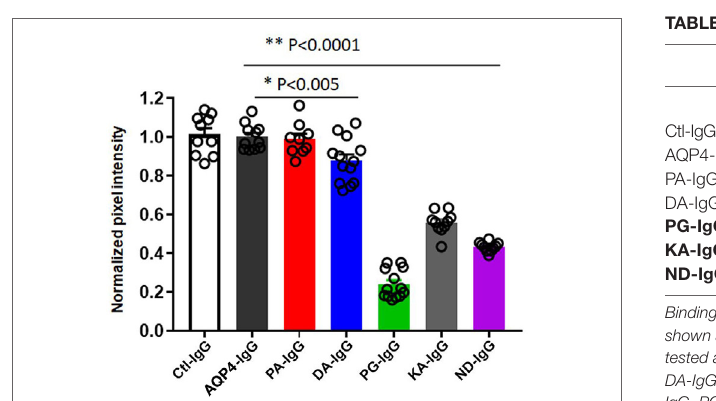
FigUre 4 | Quantification of transplacental transport of antibodies. Quanitification of optical intensity of the infrared signal (pixel intensity) from embryos exposed to maternal infrared labeled antibodies in utero . The values of each embryo is averaged and shown normalized to the average pixel intensity of an AQP4–IgG exposed litter present on the same scan to account for variability within scans (normalized pixel intensity). Transplacental transport of each antibody is shown for both litters. One-Way analysis of variance followed by Dunnett’s multiple comparisons test revealed that mice injected with PG-IgG, KA-IgG, and ND-IgG showed markedly reduced normalized infrared pixel intensity compared to AQP4–IgG (** p < 0.0001). DA-IgG showed a modest, but significant reduction, infrared pixel intensity compared to AQP4–IgG (* p < 0.005). Ctl-IgG, AQP4-IgG, and PA-IgG are not different ( p > 0.8).